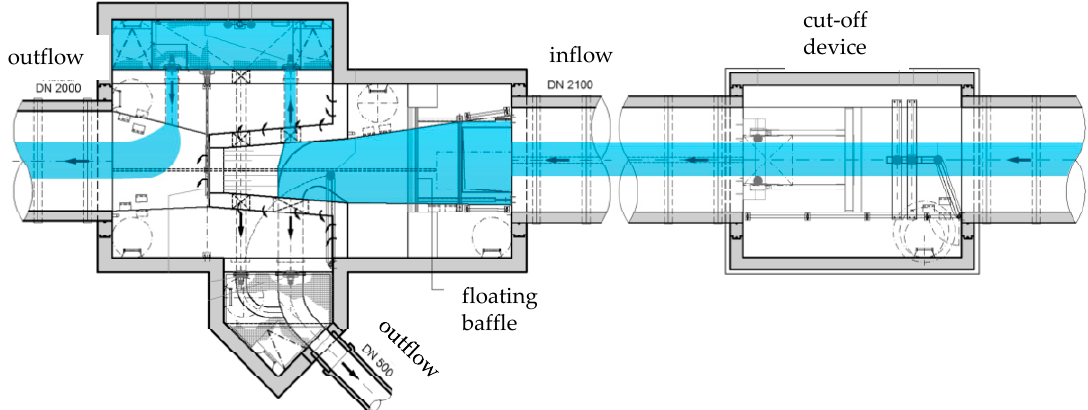
Figure 2. Technical drawing of the stormwater treatment facility with all aggregates in the initial position (dry weather conditions).